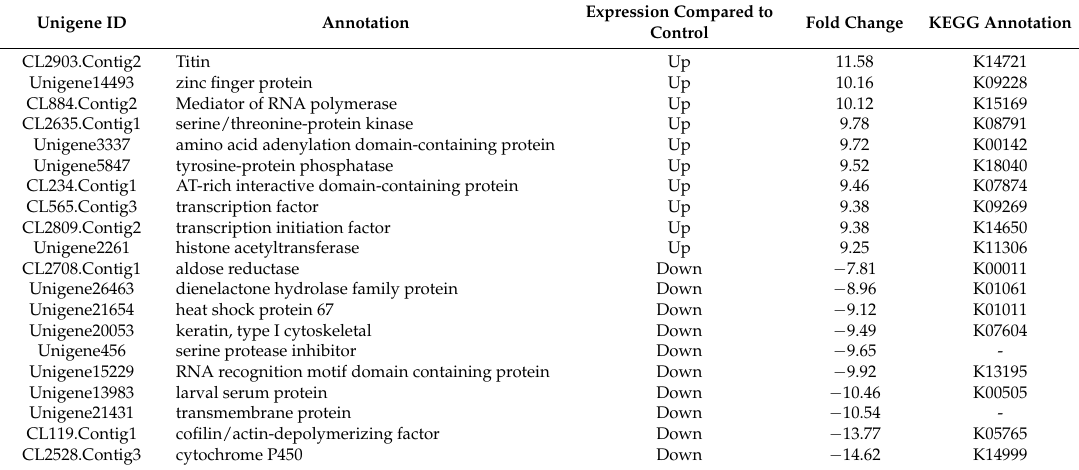
Table 3. Most significant DEUs in control samples vs. those exposed to clothianidin for 48 h. Unigene